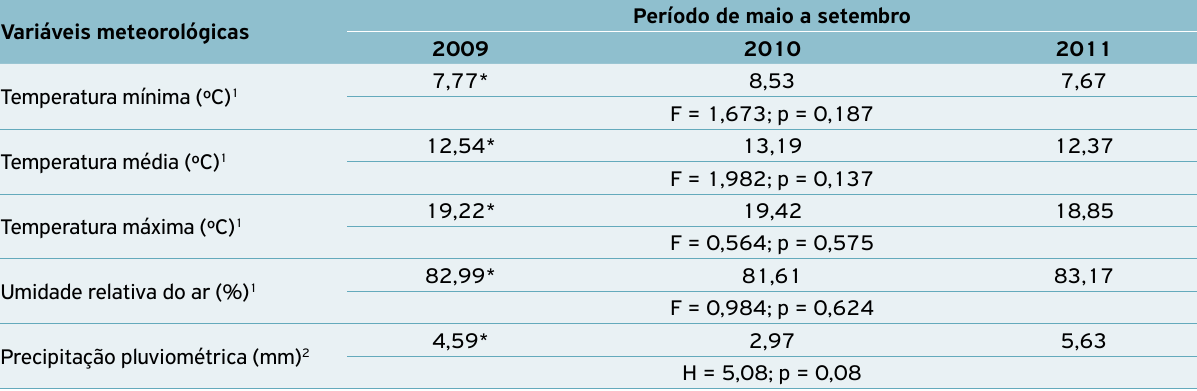
*Médias na linha não diferiram significativamente entre as safras, pelos testes F 1 ou Kruskal-Wallis 2